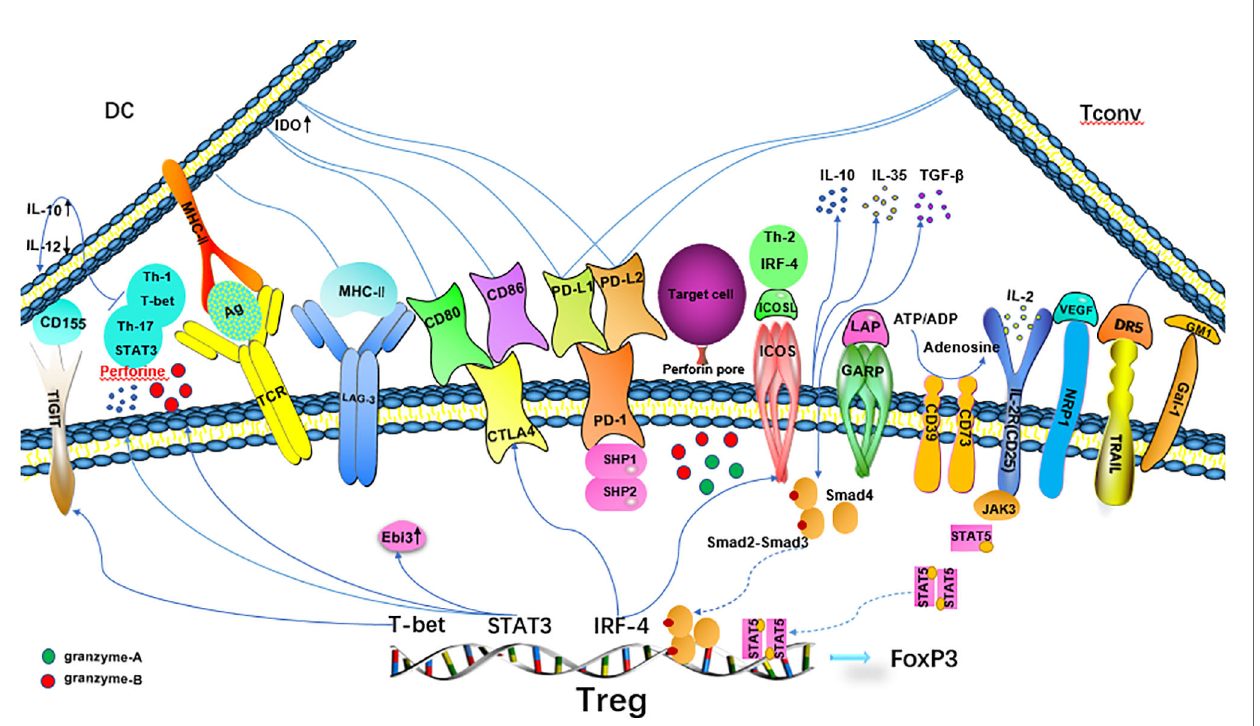
FIGURE 1 | Mechanisms of Treg suppression. CTLA-4 binds to CD80/CD86 on DCs, inhibits the maturation and antigen presentation function of DCs and increases the expression of IDO in DCs, resulting in T effector incompetence. PD-1 binds to PD-L ligands on DCs and T cells to inhibit effector T cells, and synergistically enhance the transactivation of Smad3 by TGF- b .TIGIT increases IL-10 expression and decreases IL-12 expression in DCs by binding to CD155 on DCs and inhibits the activation of effector T cells. Tregs selectively inhibit the proin fl ammatory immune response mediated by Th1 and Th17 cells. The Th2-related transcription factor IRF-4 activates Treg expression through ICOS and CTLA-4, which restricts the Th2-mediated immune response. STAT3 increases the expression of the IL-10, Ebi3, and perforin-1